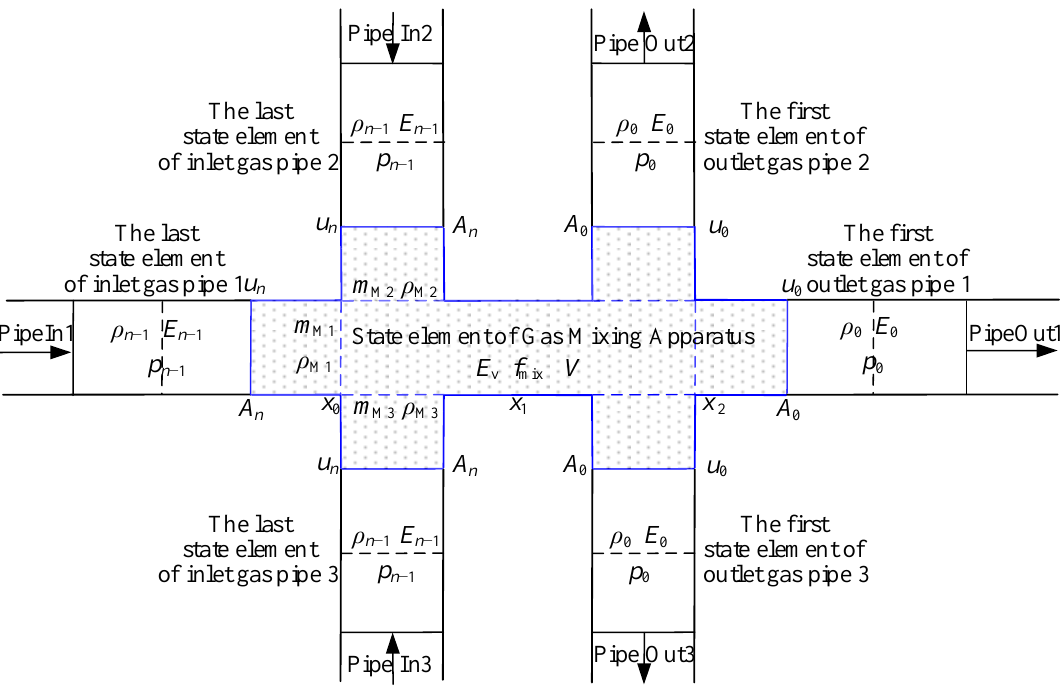
Figure 5. Finite control volume grids of gas mixing apparatus.